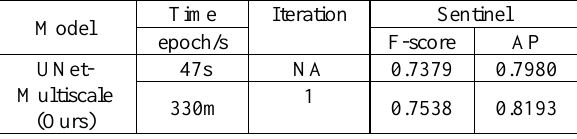
Table 4. Self-training for